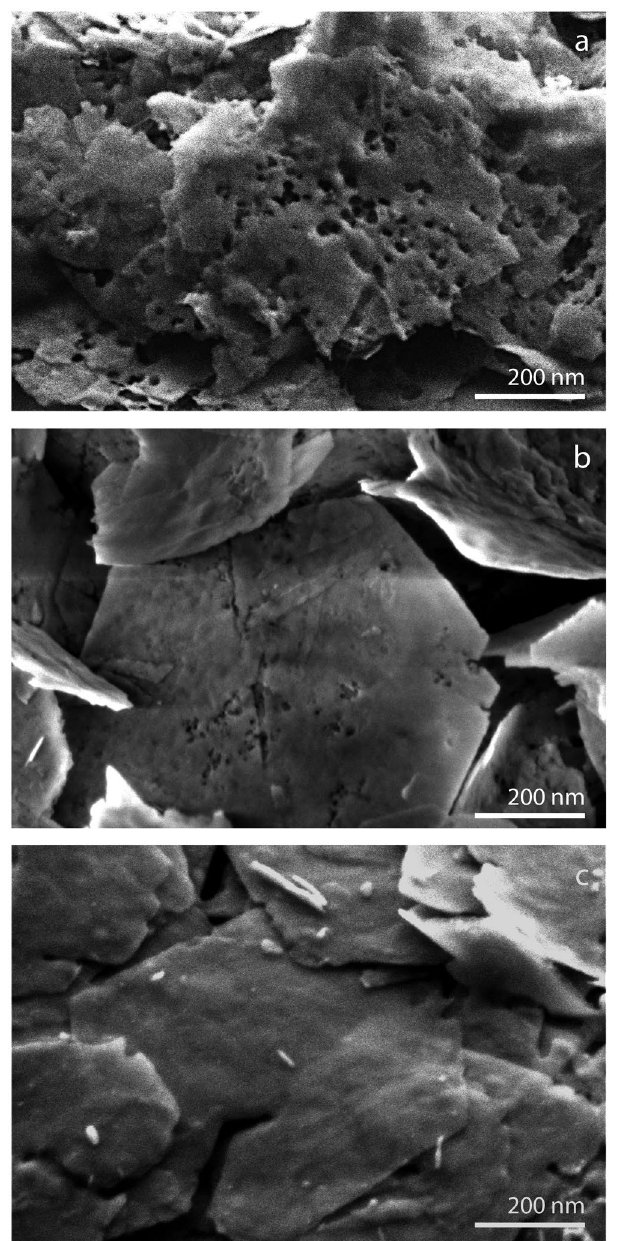
Figure 5. HR-SEM images of ( a ) LDH-H 2 O 2 -MW porous layered material; ( b ) LDH-H 2 O 2 -I porous layered material, and ( c ) LDH-I-H 2 O 2 porous layered material.